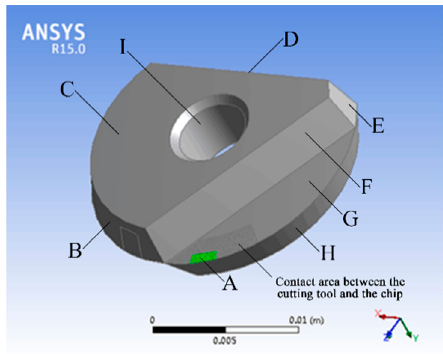
Figure 10. Overall depiction of the micro-texture ball-end milling tool.